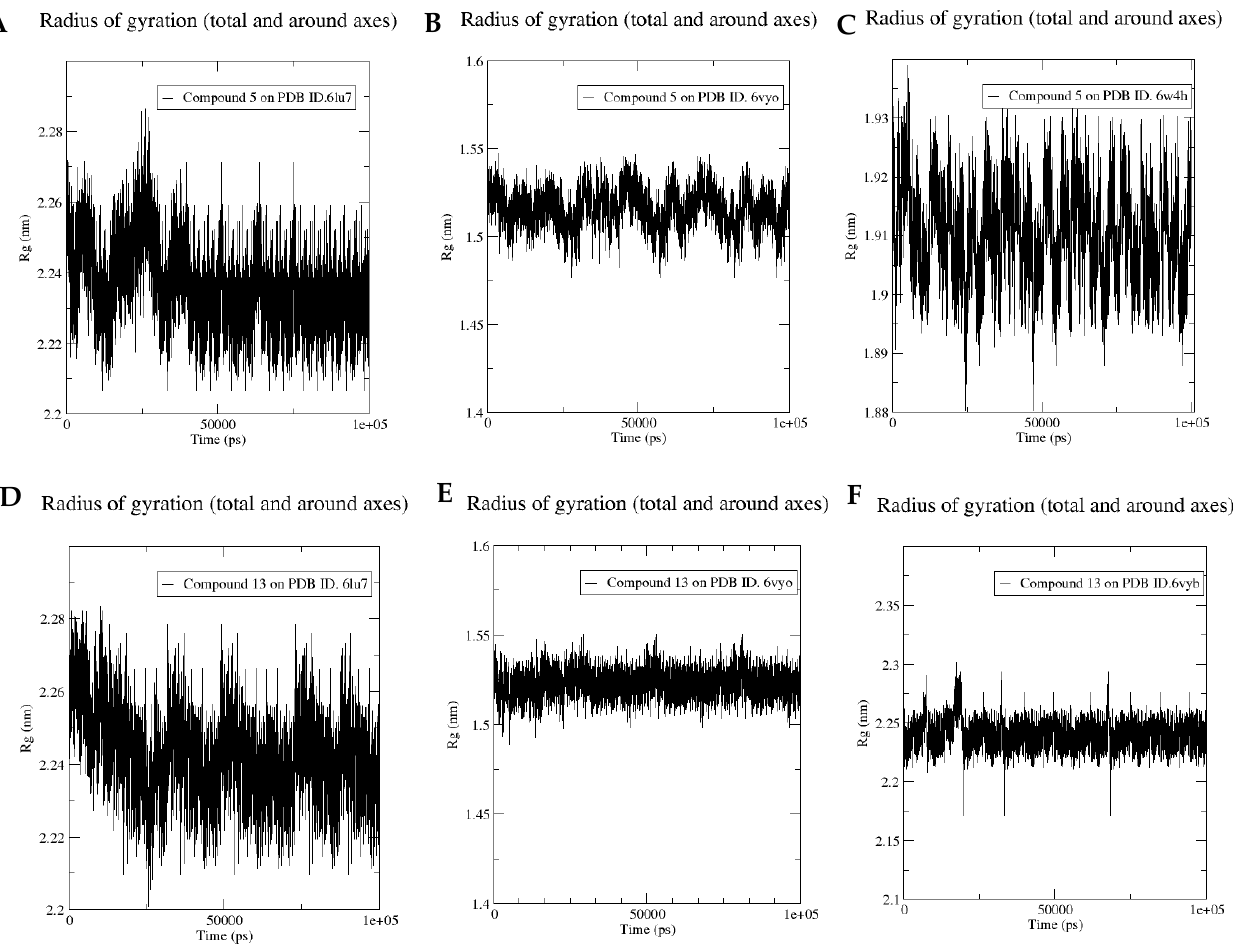
Biomolecules 2021 , 11 , x FOR PEER REVIEW 26 of 30 Figure 18. Molecular dynamics of compound 5 bound to PDB ID. 6lu7 ( A ), 6VYO ( B ) and 6W4H ( C ) and compound 13 bound to PDB ID. 6lu7 ( D ), 6VYB ( E ) and 6VYO ( F ). Radius of gyration of the protein along the simulation time.